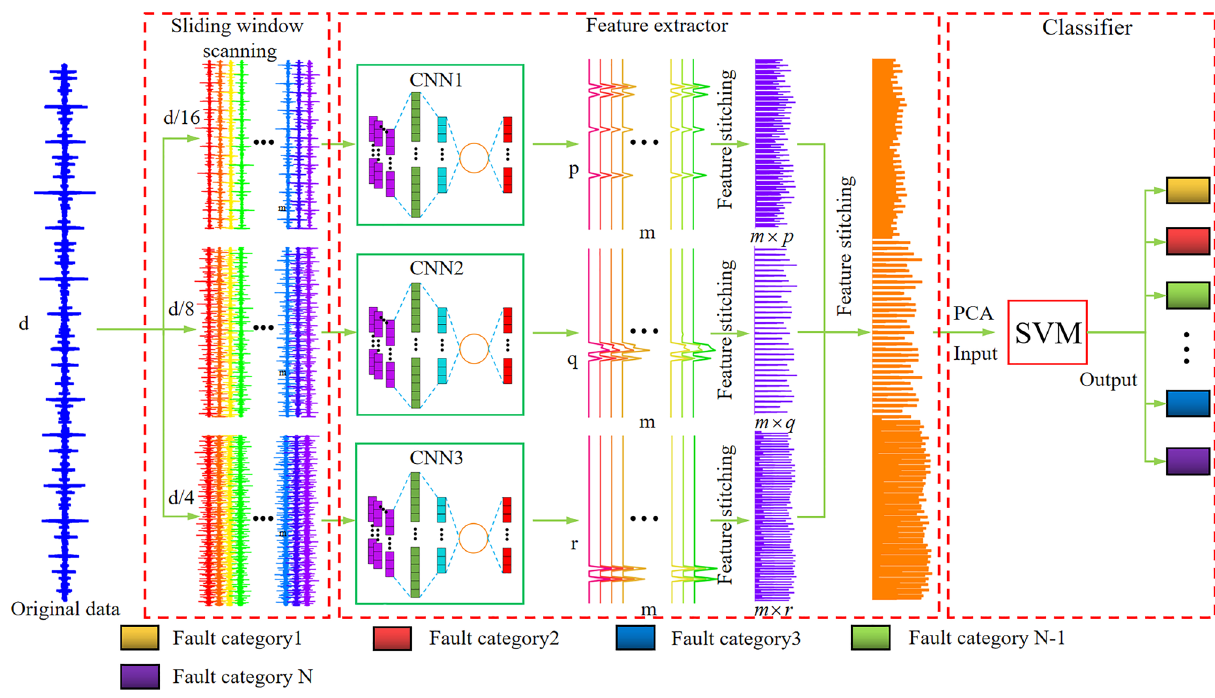
Figure 3. Processing